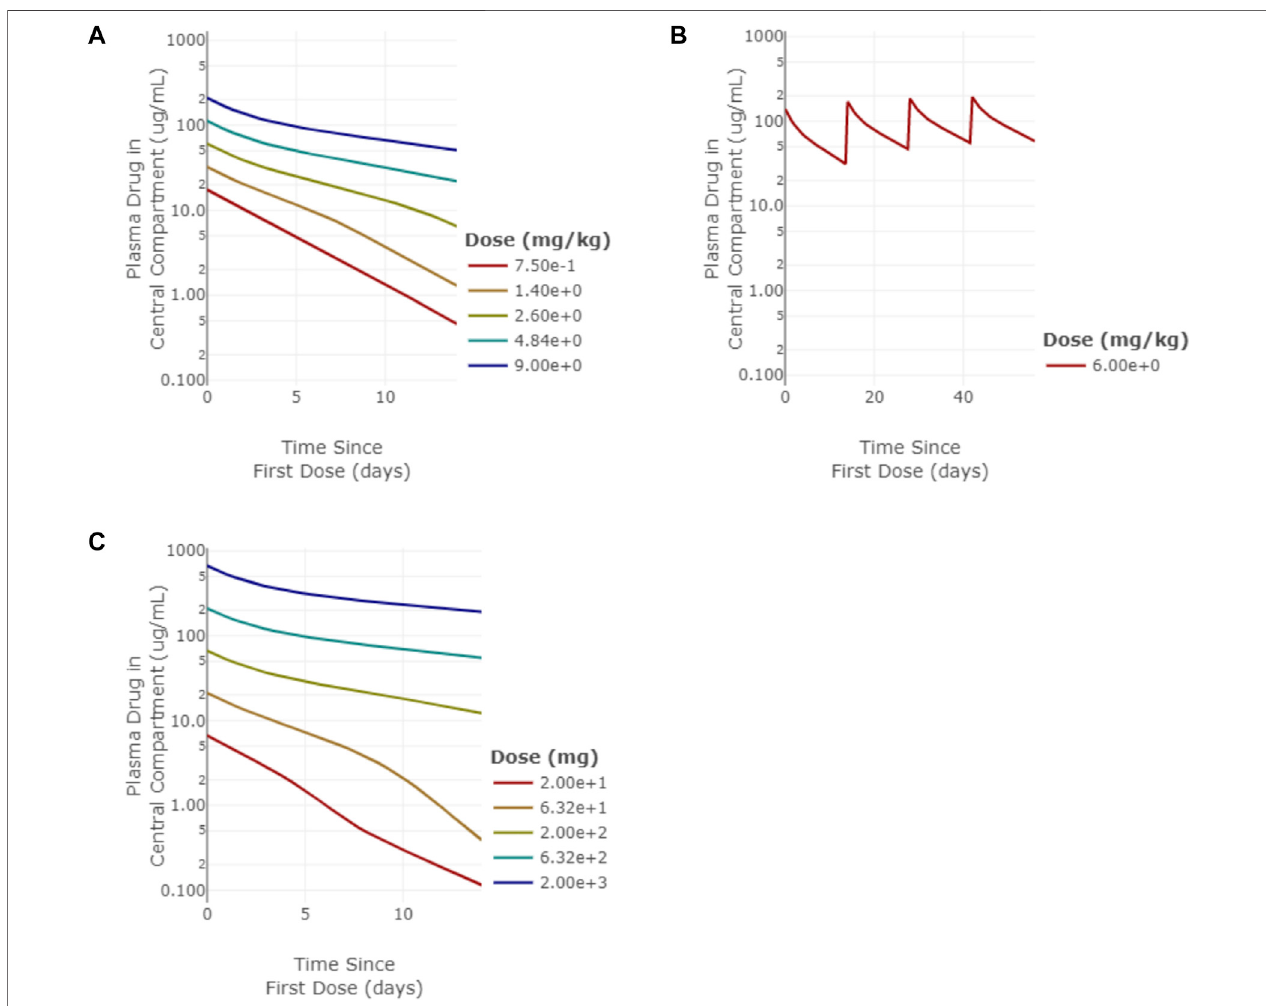
FIGURE3 | Model simulations ofpanitumumb and emibetuzumab pharmacokinetics(PK). (A) single-dose PK forpanitumumab from 0.75 – 9 mg/kg simulated out to 14 days, (B) multi-dose PK for 6 mg/kg Q2W panitumumab simulated out to 64 days, (C) single-dose PK for emibetuzumab for 20 – 2000 mg doses simulated out to 14